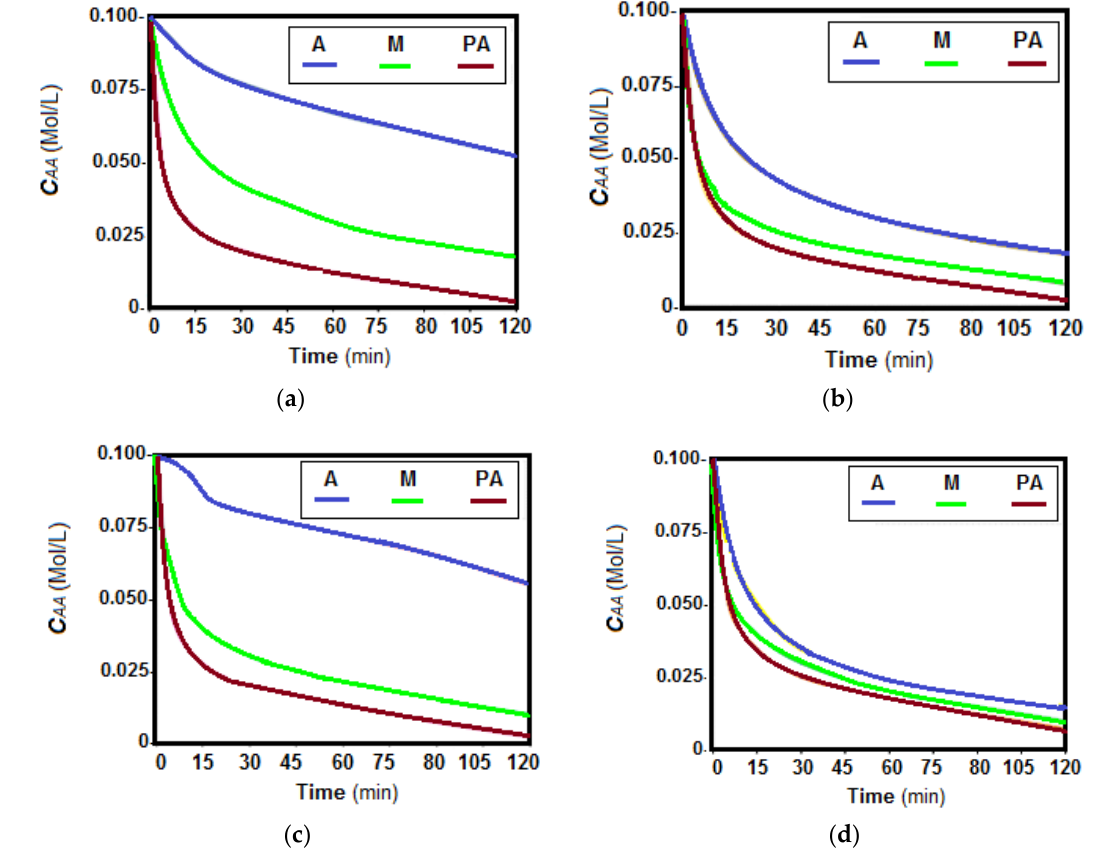
Figure 16. Variation of source phase amino acid concentration depending on the operating time at pH SP = 2 and pH RP = 7: ( a ) CA–PPM; ( b ) HEC–PPM; ( c ) MHEC–PPM; and ( d ) NaCMC–PPM. A = alanine (blue); M = methionine (green), and PA = phenylalanine (brown).